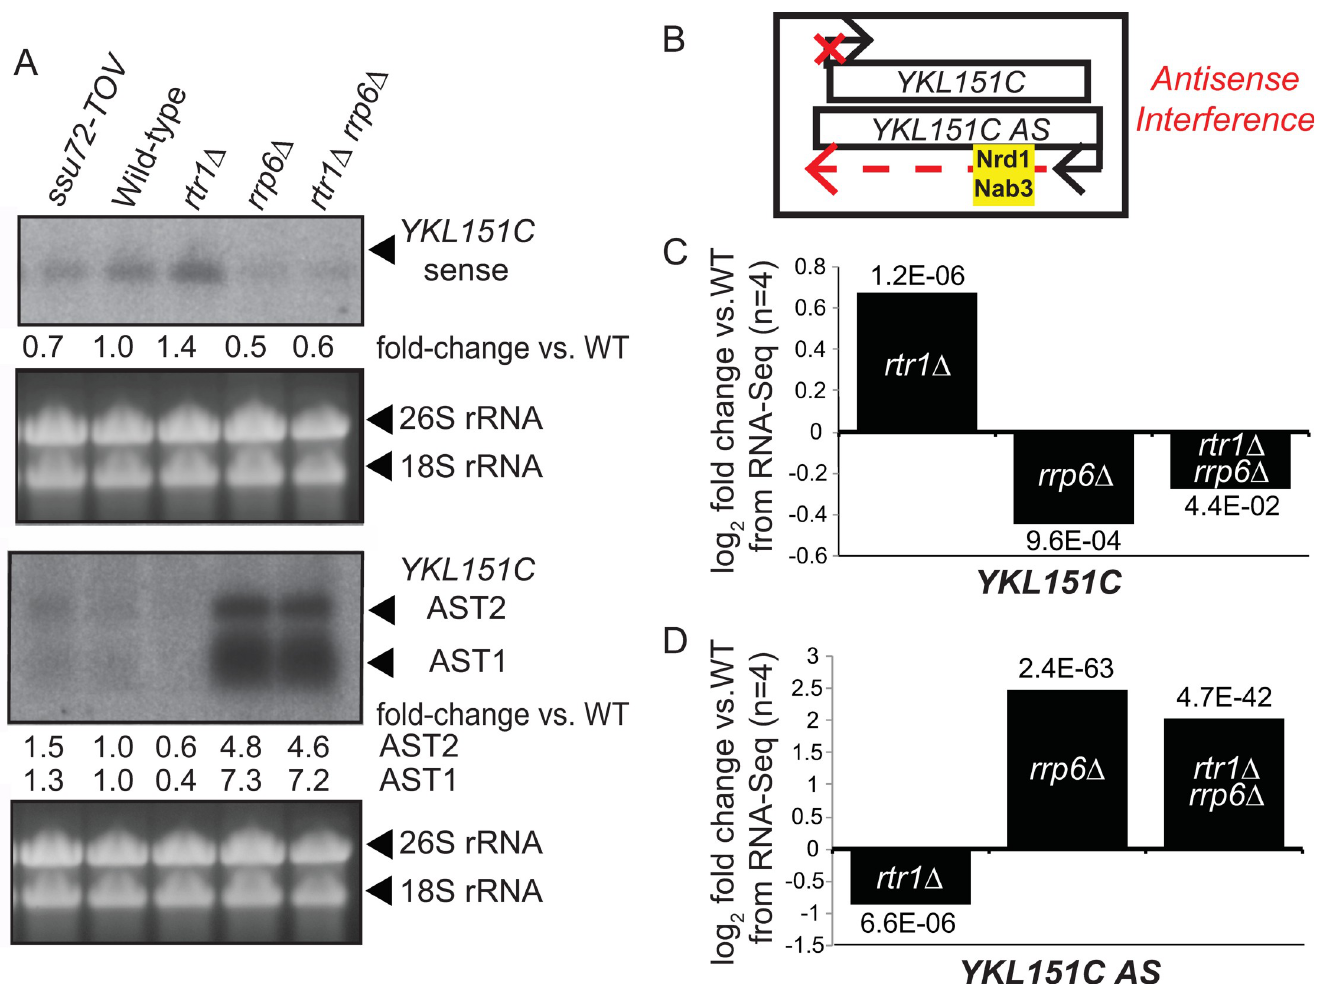
Fig 8. Analysis of YKL151C sense and antisense expression in WT and rtr1 Δ cells. A) Northern blot analysis of YKL151C sense and antisense transcripts using single- stranded RNA probes. Band intensity relative to WT is shown under each relevant panel with labels found to the right. B) Schematic representation of YKL151C sense and antisense expression. C&D) Summary of RNA-Seq expression analysis of YKL151C sense and antisense transcript expression, FDR values are displayed above/below bar as calculated by edgeR.